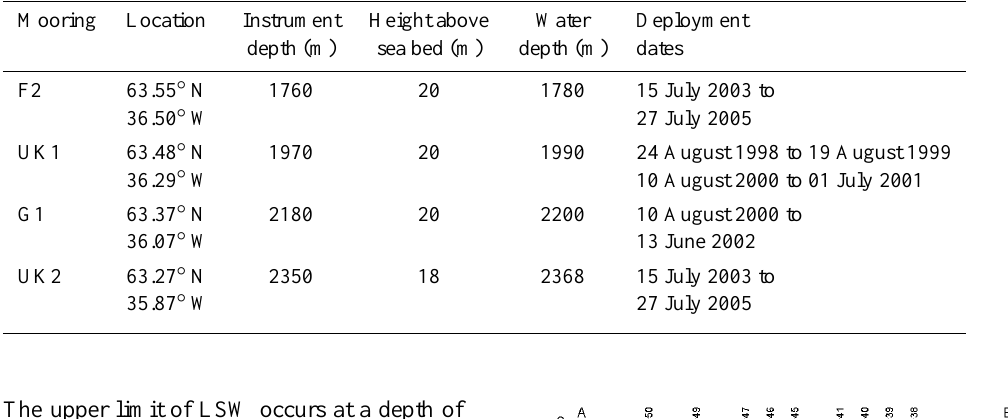
Table 1. Locations, depths and deployment dates of moorings in Fig. 2.